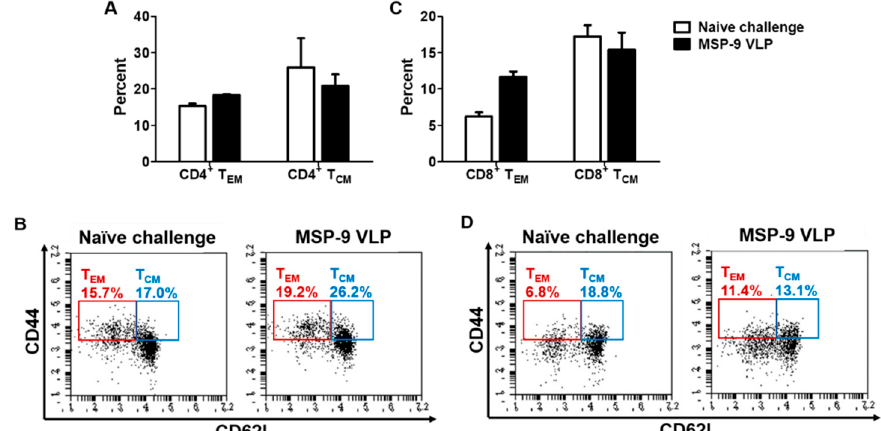
Figure 4. Memory T cell responses in spleen. Populations of CD4 + and CD8 + memory T cells were analyzed at day 6 post challenge using flow cytometry. MSP ‐ 9 VLP showed higher CD4 + ( A ) and CD8 + ( B ) effector memory T cell responses compared to the naïve challenged group. Numbers indicate the percentage of cell populations in each quadrant ( B , D ). The error bars represent SEM.